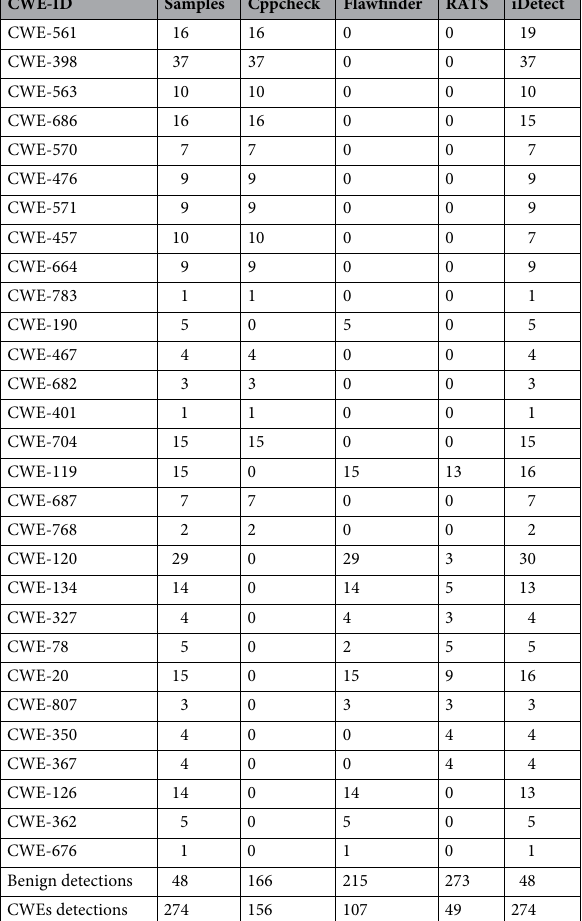
Table 2. The multiclass classification evaluation results of the three SATs and iDetect on the TinyOS evaluation